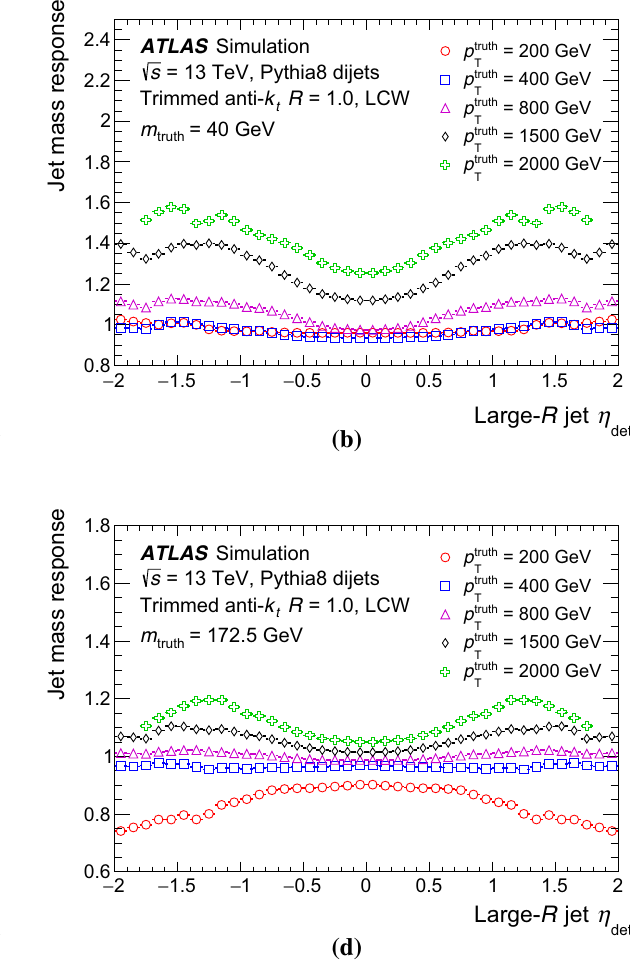
Fig. 3 The response for a the jet energy and b – d the jet mass of large- R jets. The jet energy response is presented as a function of jet detector pseudorapidity η det for several values of the truth jet energy, ranging from200GeVto2TeV.Thejetmassresponseispresentedasafunction of jet pseudorapidity for several values of the jet transverse momentum from 200 GeV to 2 TeV and for three representative values of the truth dure as for the jet energy calibration. The mass calibration is is presented in Fig. 3 for three representative values of the truthjetmass:40GeVinpanel(b),the W bosonmassinpanel (c), and the top quark mass in panel (d). The mass response is close to unity for jets with p T between 200 and 800 GeV